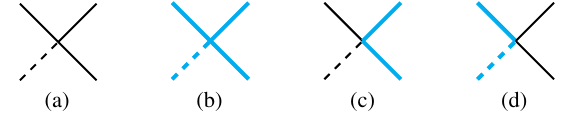
FIG. 9. Interaction vertices. Thin black (thick cyan) lines correspond to the first (second) field, and solid (dashed) lines correspond to the classical (response) field. (a) u 1 ϕ 3 1